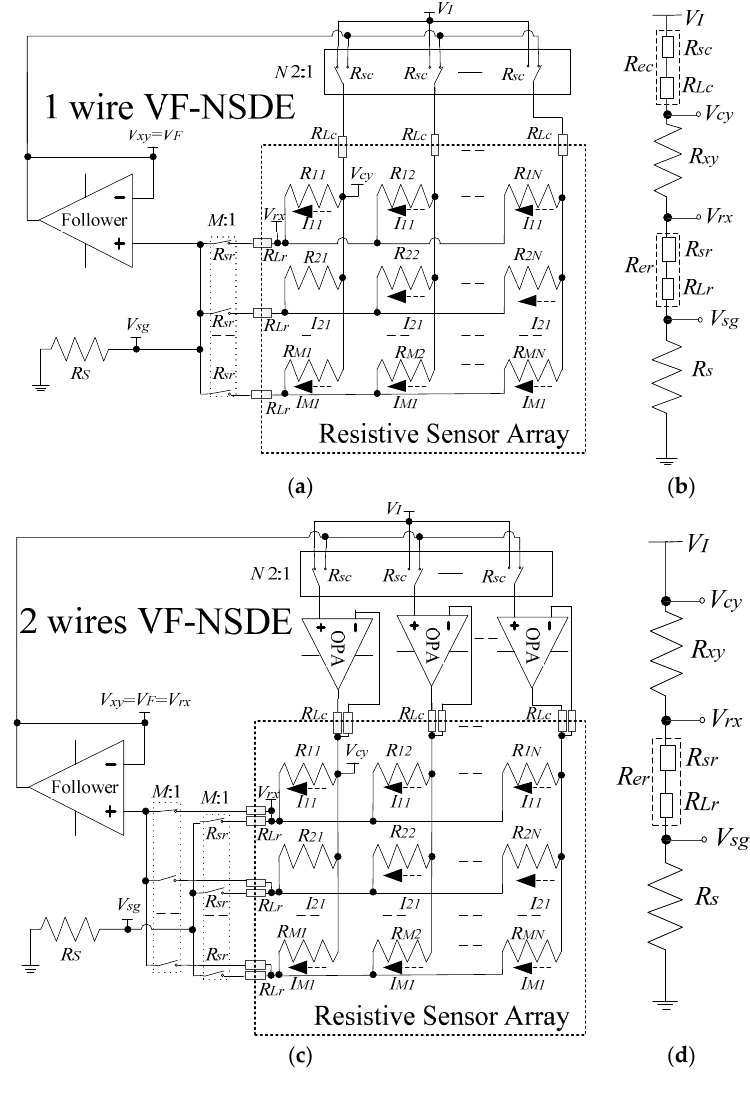
Figure 1. ( a ) One-wire VF-NSDE circuit (Circuit A); ( b ) simplified measurement circuit of a one-wire VF-NSDE circuit (Circuit B); ( c ) two-wire VF-NSDE circuit (Circuit C); and ( d ) simplified measurement circuit of a two-wire VF-NSDE circuit (Circuit D).